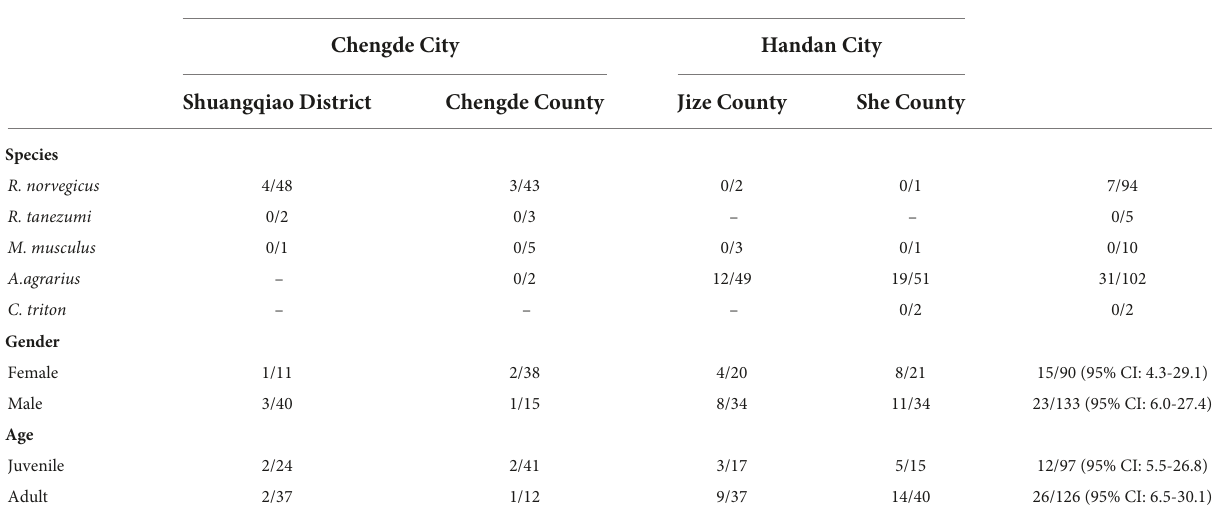
TABLE 2 Bartonella sp. DNA detection in rodents collected in Hebei, China. Parameters Location